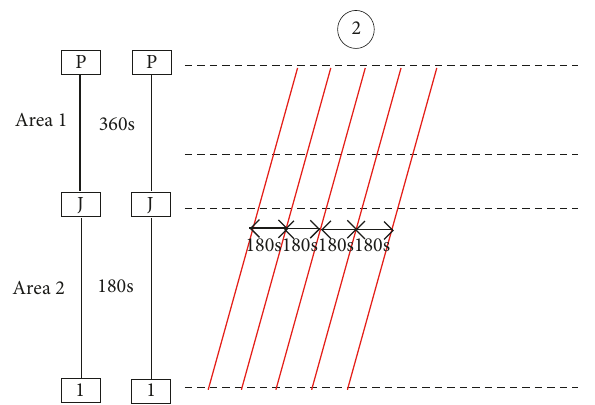
Figure 5: Only passenger demands in area 2 can be satisfied.